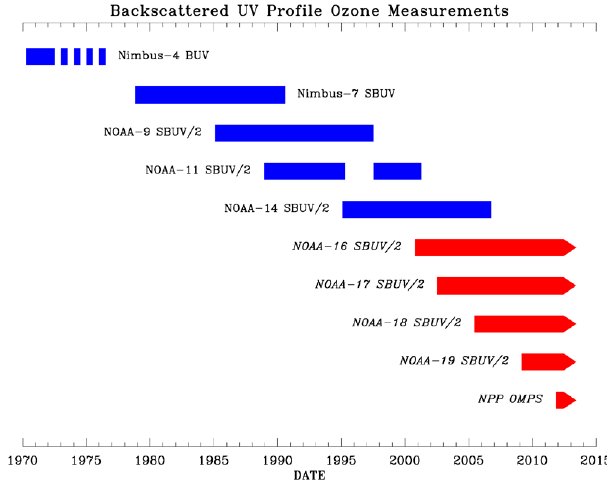
Fig. 1. Timeline of satellite BUV instruments used to measure stratospheric profile and total column ozone for the V8.6 data set. Inactive instruments are shown in blue, and operational in- struments are shown in red. The dashed portion of the Nimbus-4 BUV segment indicates the significantly reduced data coverage af- ter July